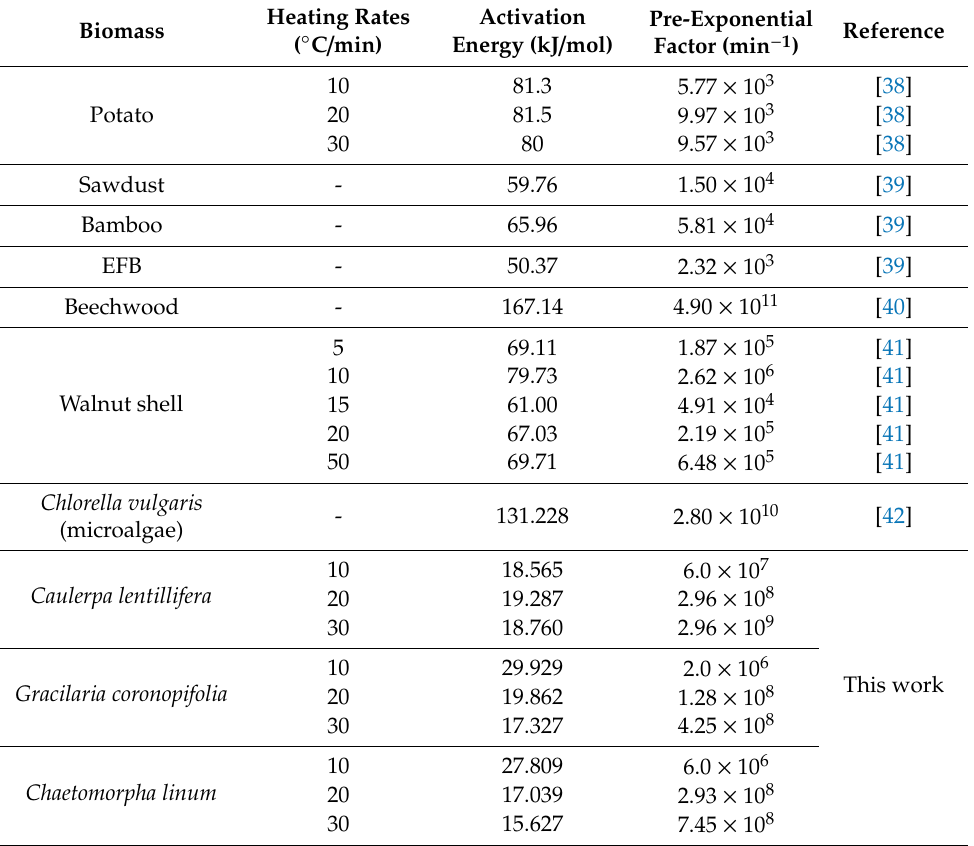
Table 3. Kinetic parameters of other biomass